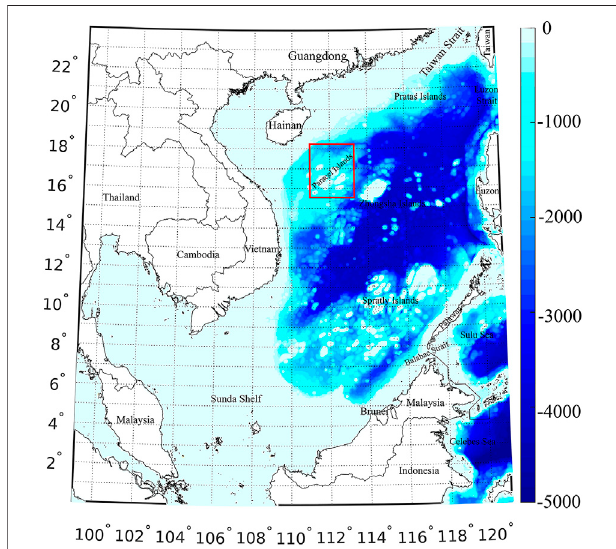
FIGURE 1 | Study area and the associated bathymetry. The region enclosed in the red rectangle represents the surveyed area of airborne gravimetry over the Paracel Islands.